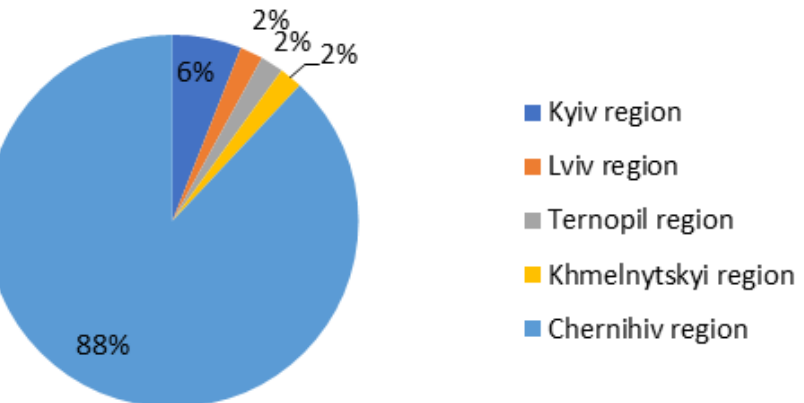
Figure 3. The respondents’ place-of-study (image developed by the authors).